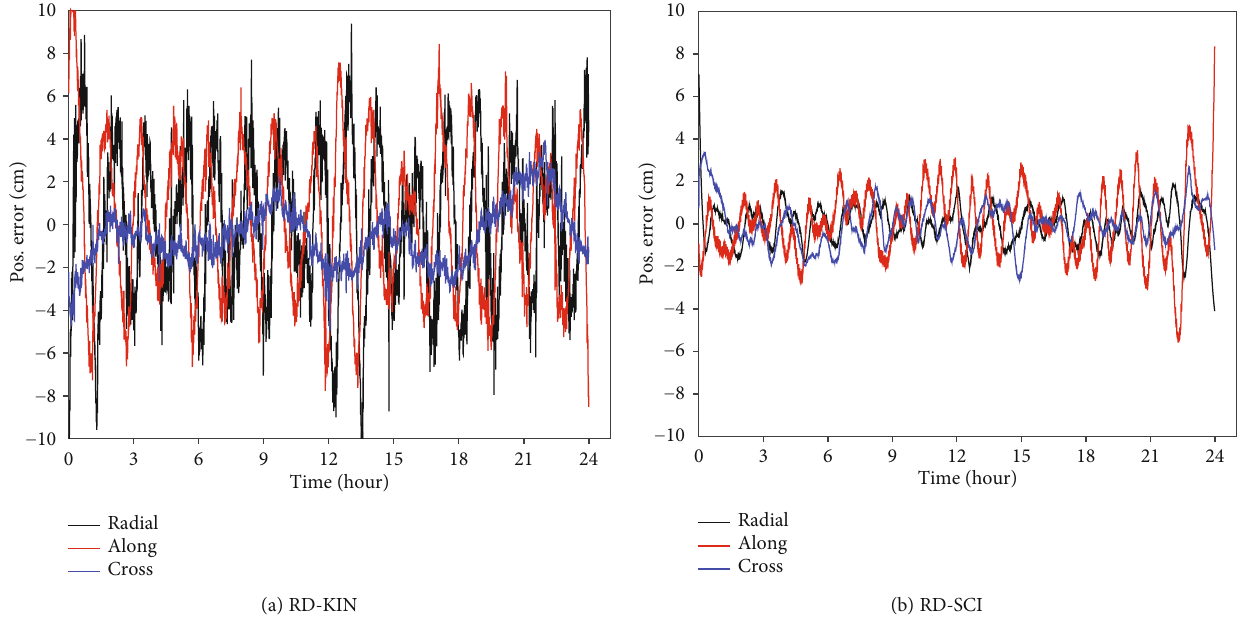
Figure 5: Position errors of the GRACE-A satellite in the radial, along-track, and cross-track directions obtained on 14 July